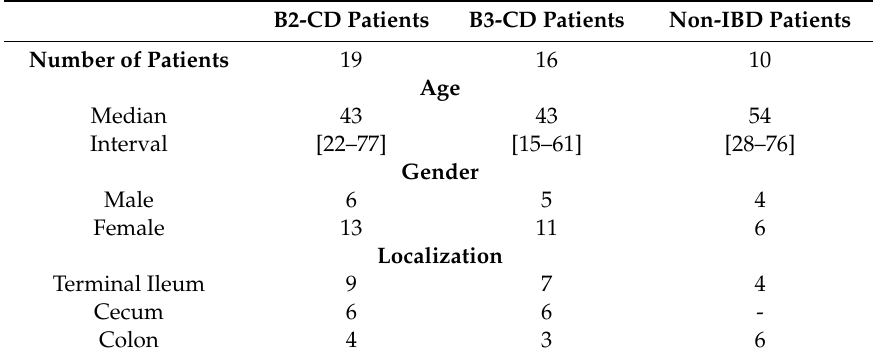
Table 1. Information of patient characteristics.